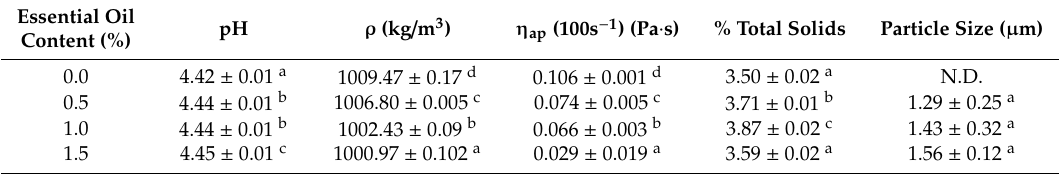
Table 1. Physical–chemical properties of the chitosan (CS) + Ruta graveolens L. essential oil (RGEO) FFE. Essential Oil Content (%)